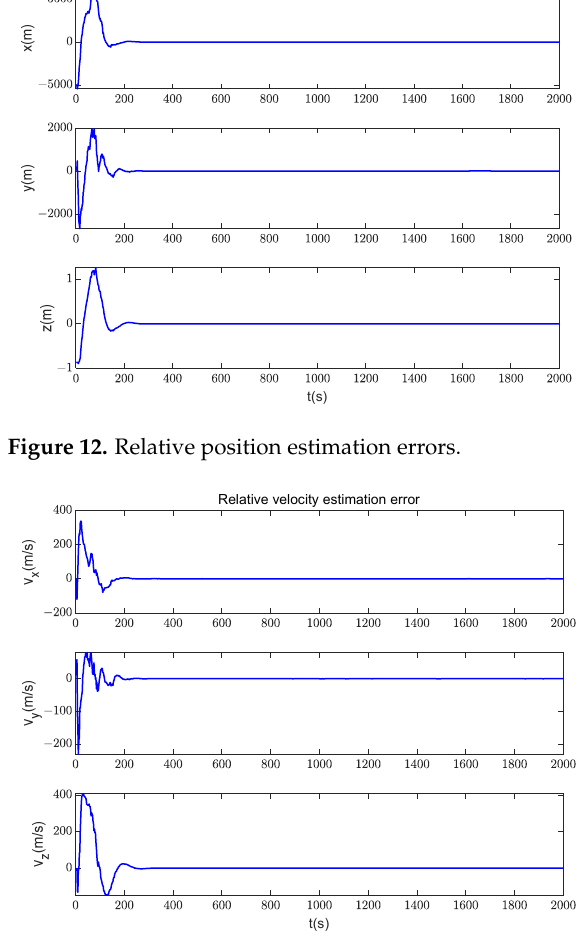
Figure 13. Relative velocity estimation errors.